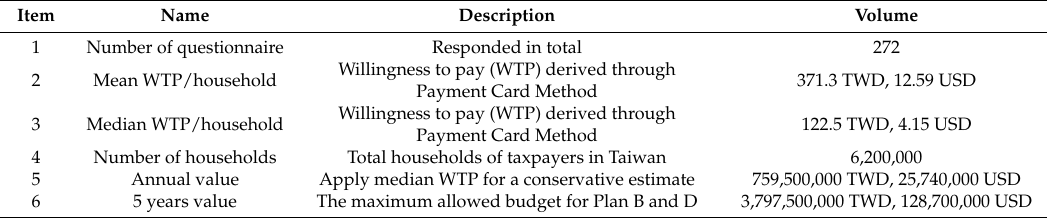
Table 3. The estimation of WTP for C1-Cost in Plan B and